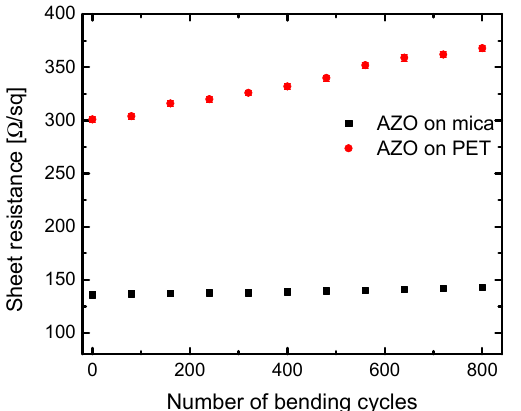
Figure 5. Sheet resistance dependence of the number of bending cycles for AZO on mica and AZO on PET layers.